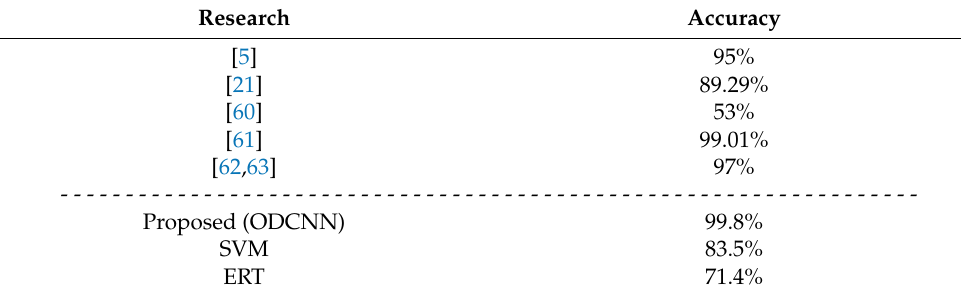
Table 8. Comparison with previous